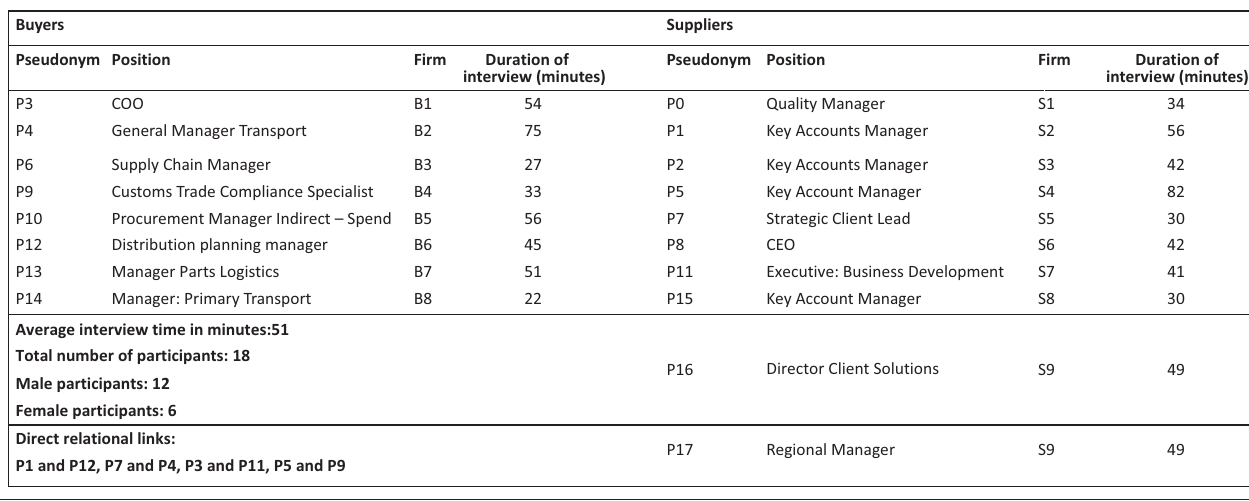
FIGURE 1: Participant and company